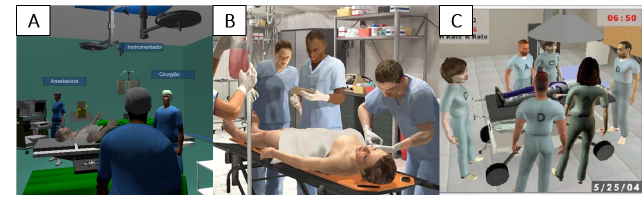
Fig. 1: CVEs applied to surgical team training and evaluation: A) SimCEC B) 3diTeams and C)